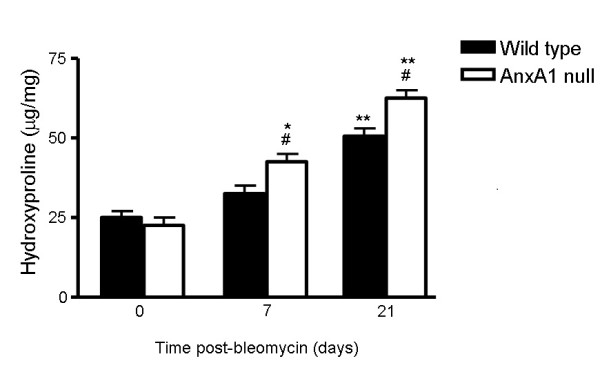
Leukocyte influx into the lung tissue. Semiquantitative analysis of the histological sections showing intravascular polymorphonuclear (PMN) and monocytes (mono), and transmigrated PMN and MPC in lung tissue. Wild type and AnxA1 null mice were analyzed at 0, 7 and 21 days post-bleomycin i.t. administration as described in Methods section. Data are mean ± SEM from 5 mice per time point. *P < 0.05 versus 0 time point wild type group values; **P < 0.01 versus 0 time point wild type group values; ***P < 0.001 versus 0 time point wild type group values; #P < 0.05 versus corresponding wild type group values; ###P < 0.01 versus corresponding wild type group values.